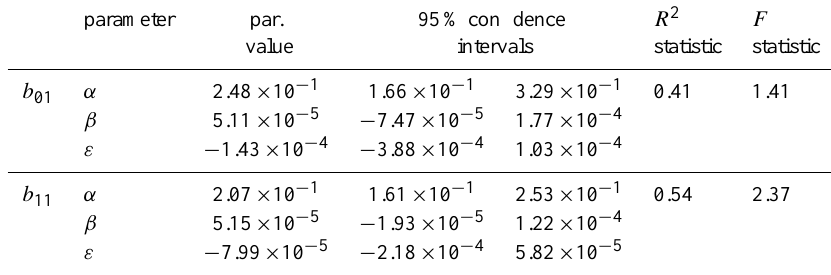
Table 2. Parameters and statistics of the seasonal derived multiple linear regression model of the Pangani basin.